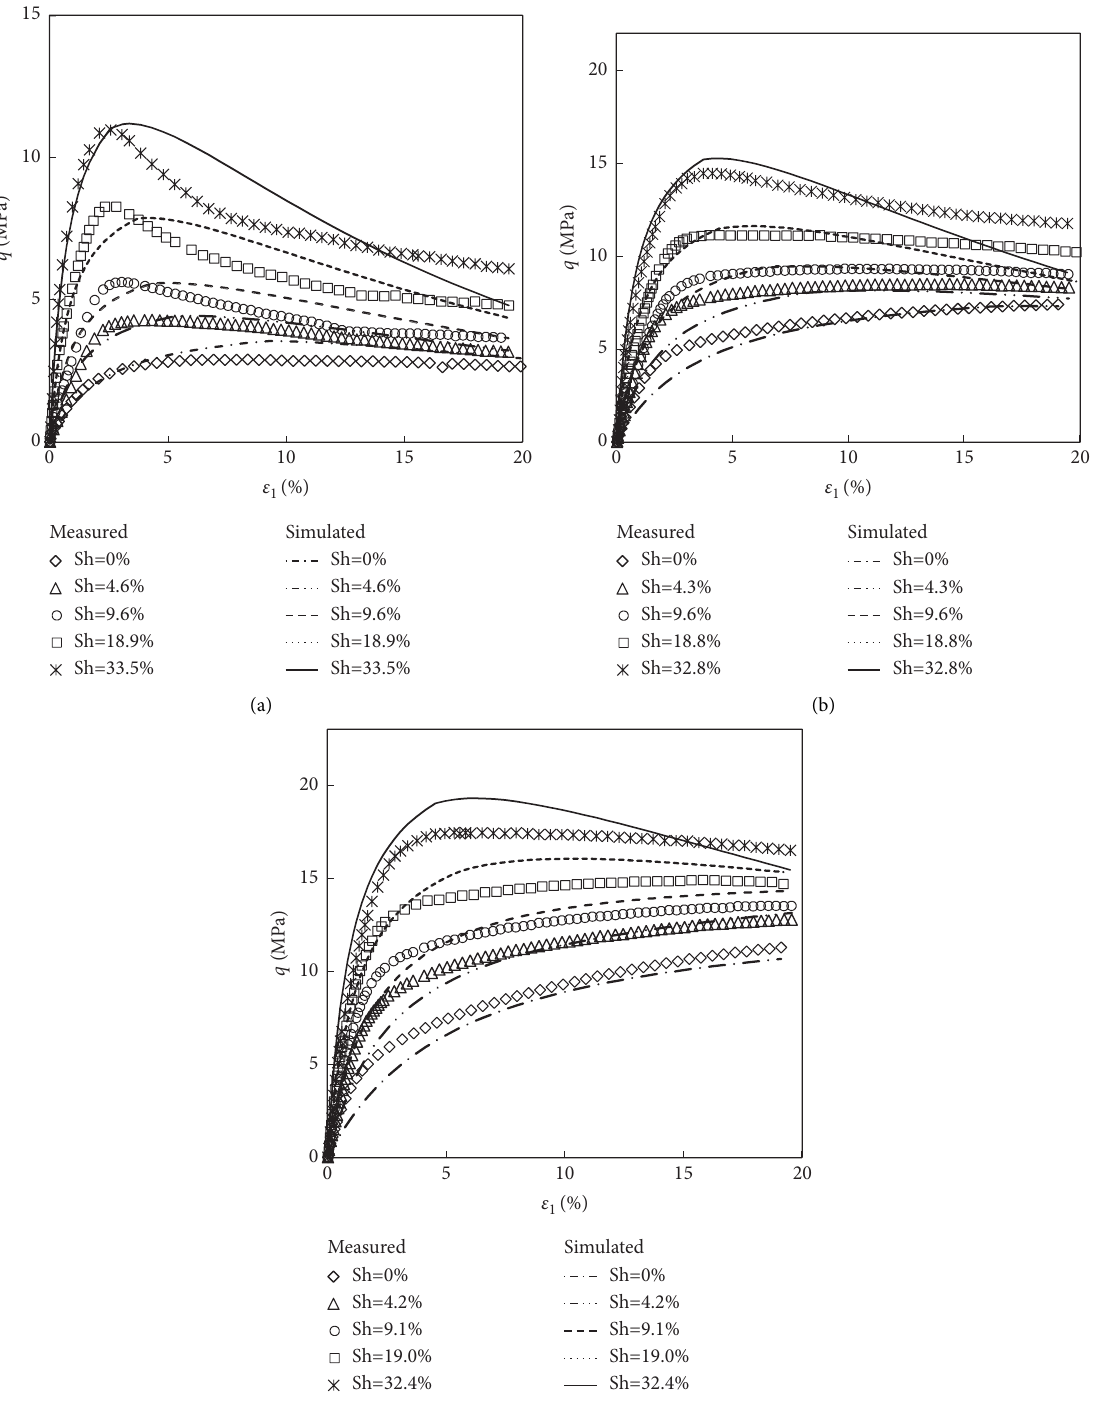
Figure 10: Comparisons of the calculated and experimental stress-strain curves for HBS: (a) σ �